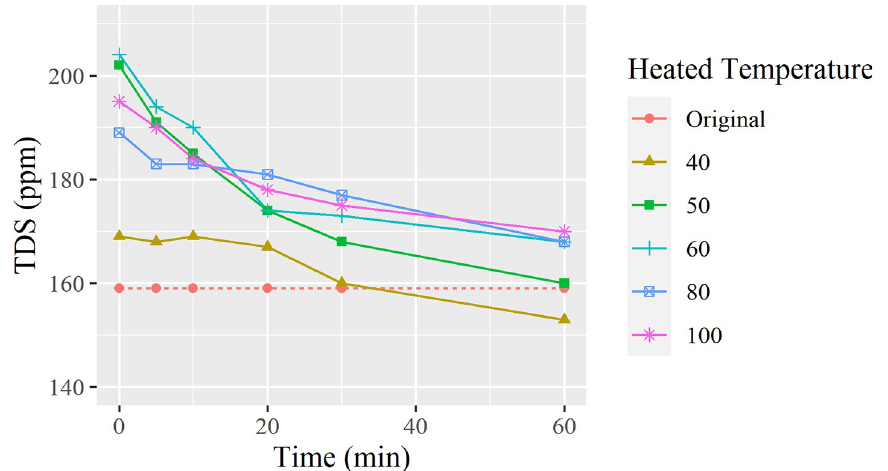
Fig 2. TDS change overtime for each starting temperature.